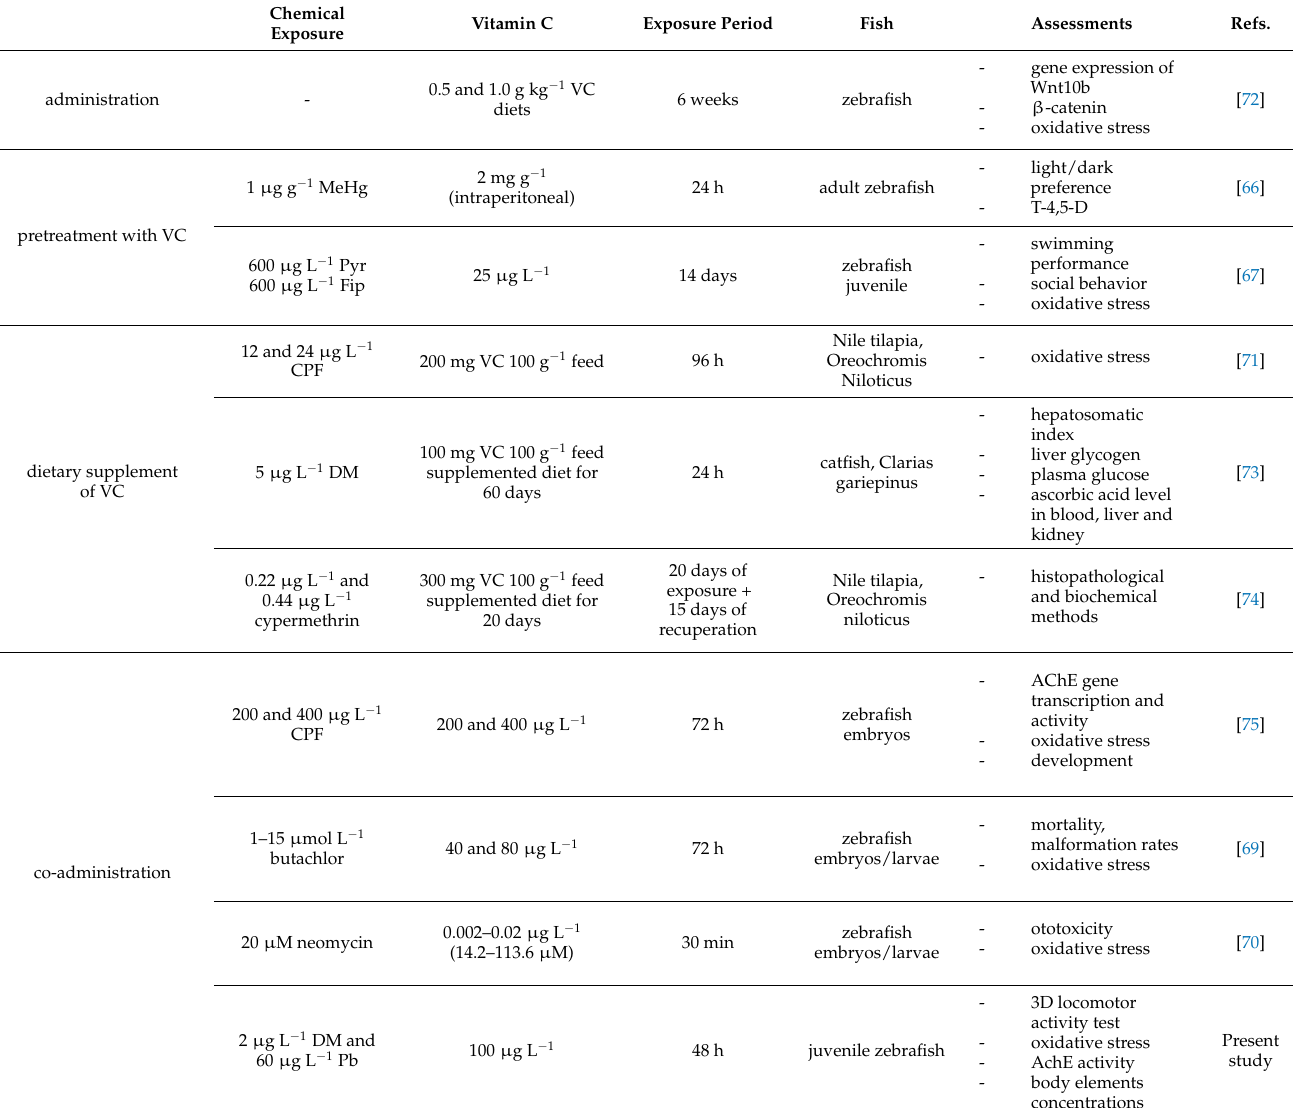
Table 1. Summary of fish studies regarding the protective/recuperative role of vitamin